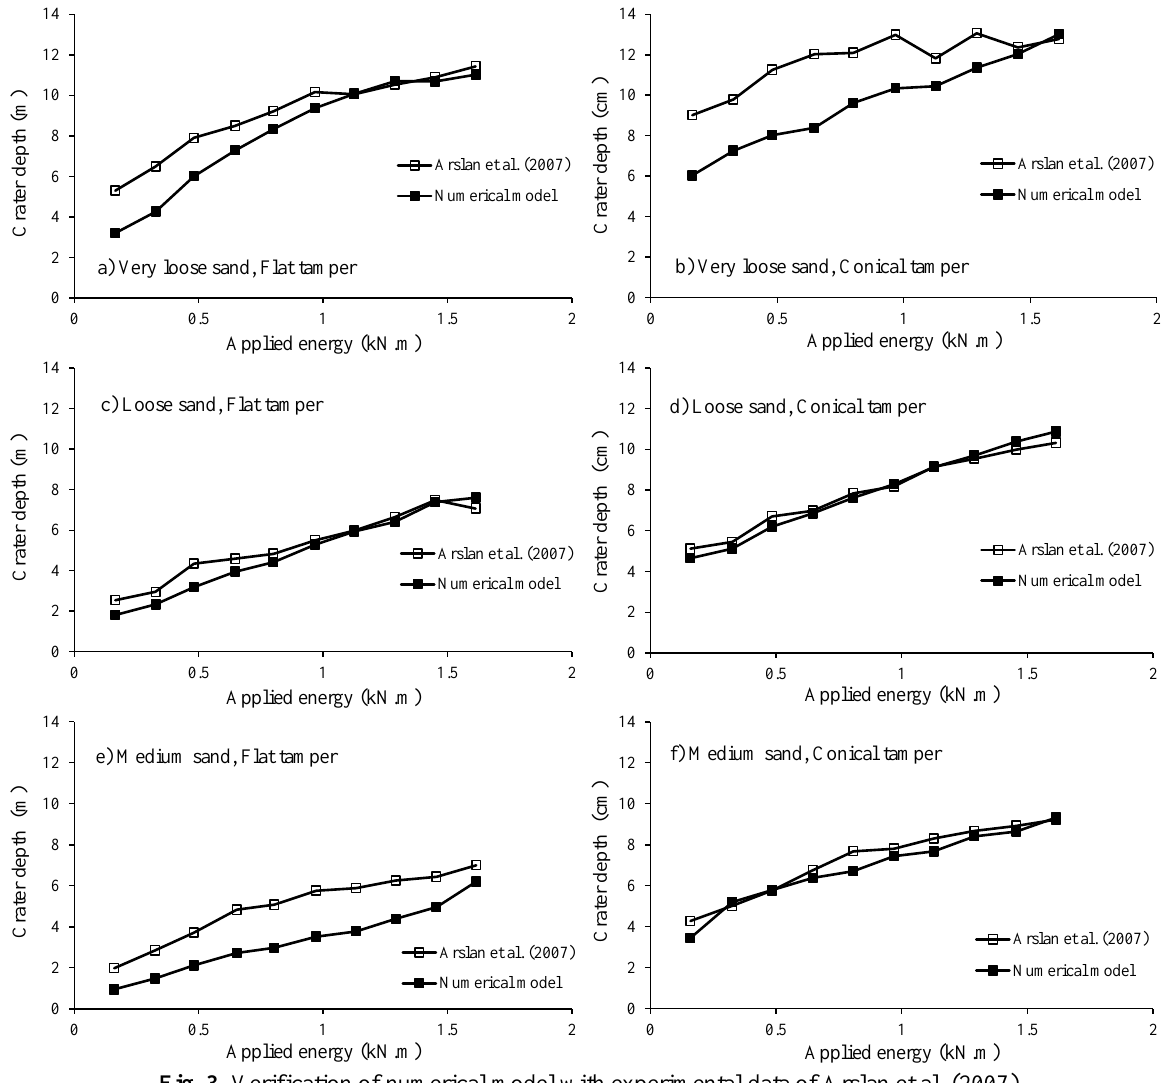
Fig. 3. Verification of numerical model with experimental data of Arslan et al.